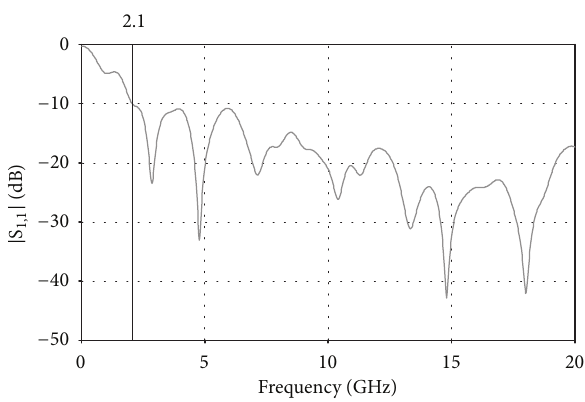
Figure 16: Reflection coefficient magnitude of a semiplanar conical antenna with elliptical aperture and